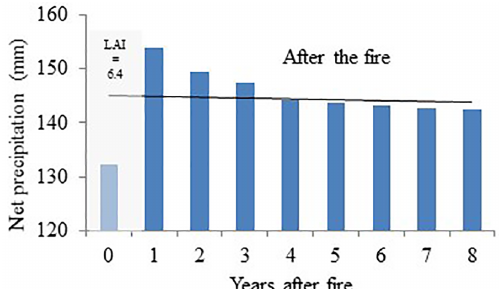
Figure 2. Modeled annual net precipitation before and 8 years af- ter a forest fire after van Dijk and Bruijnzeel (2001) interception model. Precipitation conditions are those measured during 2004.